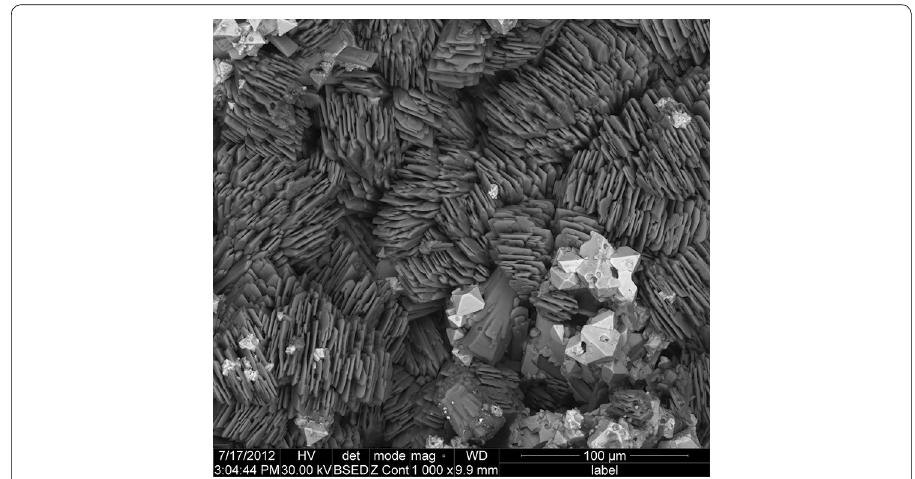
Fig. 1 Backscattered electron SEM micrograph of the intact scaling surface. Lamellar (Ba,Sr)SO 4 crystals appear in grey , the close to idiomorphic Galena (PbS) crystals appear in light grey